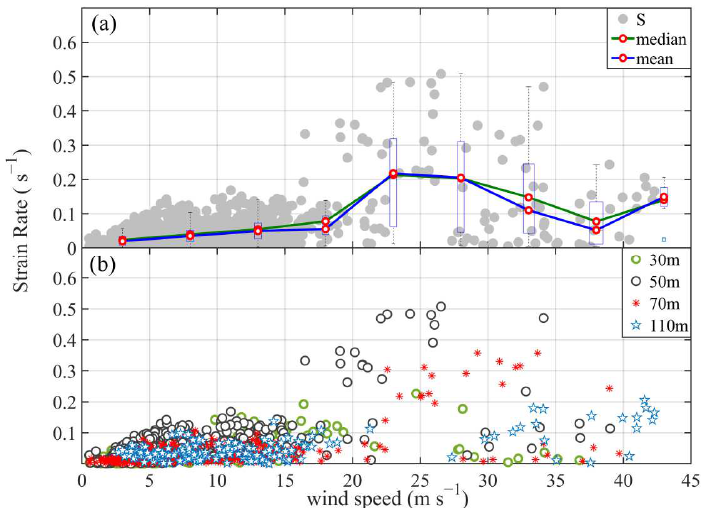
Figure 14. ( a ) S as a function of u n during landfall of Typhoon Maria. The blue line with the red circles is the bin median average S at 5 m s –1 intervals of u n from the observations. The yellow line with red circles is the bin mean average S at 5 m s –1 intervals of u n from the observations. ( b ) Strain rate ( S ) at four heights plotted versus wind speed ( u n ) during landfall of Typhoon Maria. The strain rate was calculated using Equation (7).